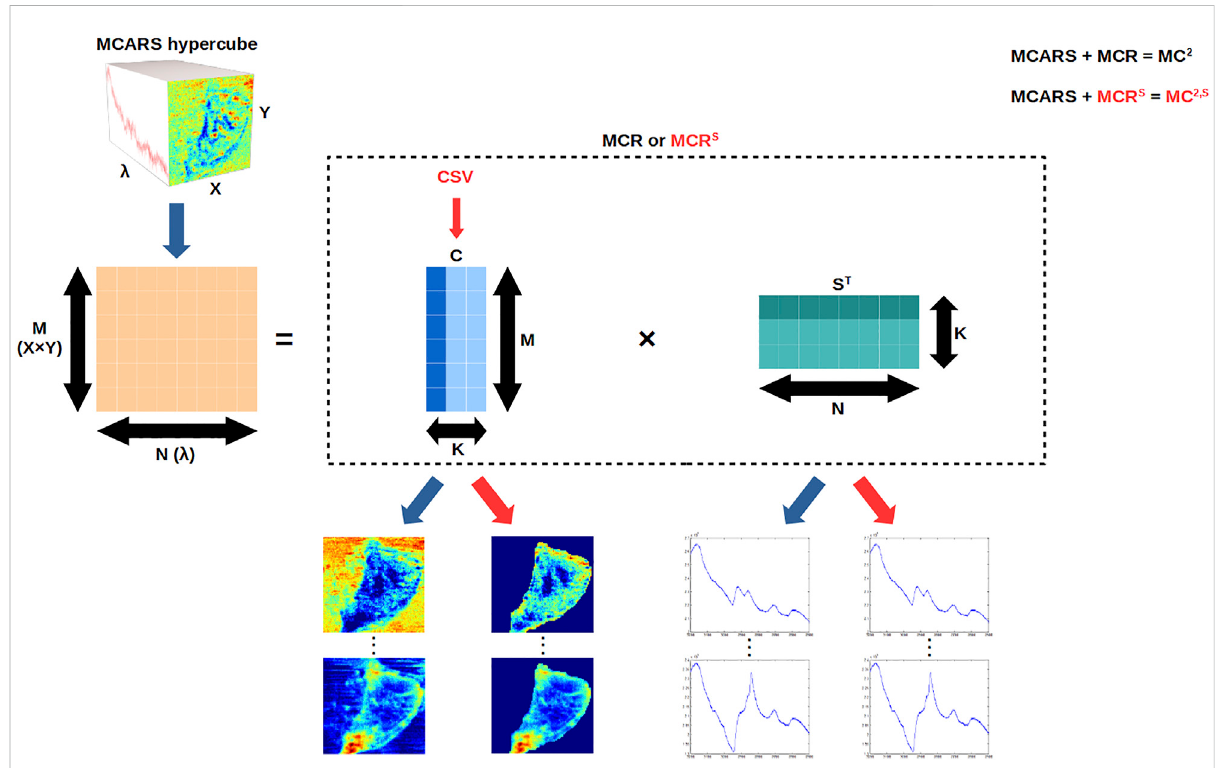
FIGURE 1 MC 2 andMC 2,S frameworks.MCARSdataarelinearized,andthenMCRorMCR S isappliedtocomputetheconcentration M × K -matrix C andthe spectra K × N -matrix S T iteratively. Finally, an image (reconstructed from C ; segmented in the case of MCR S ) and a spectrum (stored in S T ) are available for each of the K extracted components. CSV stands for the Chan – Sandberg – Vese method, which is used as a segmentation constraint in MCR S